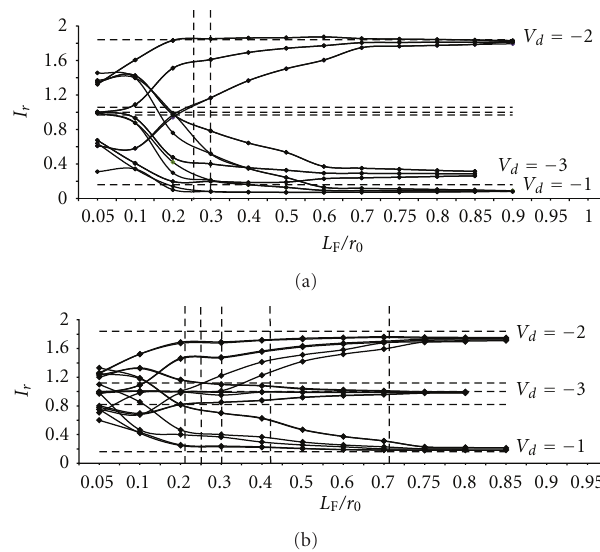
Figure 6: Calculated over 100 realizations, mean and maximum values of I r obtained with di ff erent topological charges V d for angles of rotation Δ = 180 ◦ (a) and Δ = 120 ◦ (b). Here L F is Fried’s coherence length. Horizontal dashed lines in the upper and lower parts of the pictures show the regions where values of I r are greater and lesser than 1.84 and 0.16. In the middle part of Figure 5(a) dashed lines correspond to I r = 1 with threshold values I r = 0 . 97 and I r = 1 . 06; in Figure 5(b) they correspond to I r = 1 with threshold values I r = 0 . 82 and I r = 1 . 12. Vertical dashed lines in Figure 5(a) show values of L F /r 0 B equal to 0.26 and 0.30, while in Figure 5(b) equal to 0.22, 0.25, 0.30, 0.43, and